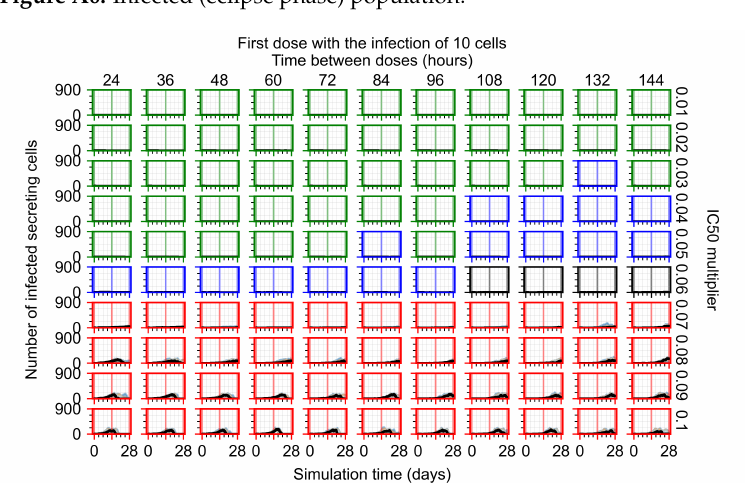
Figure A7. Infected (secreting extracellular virus)